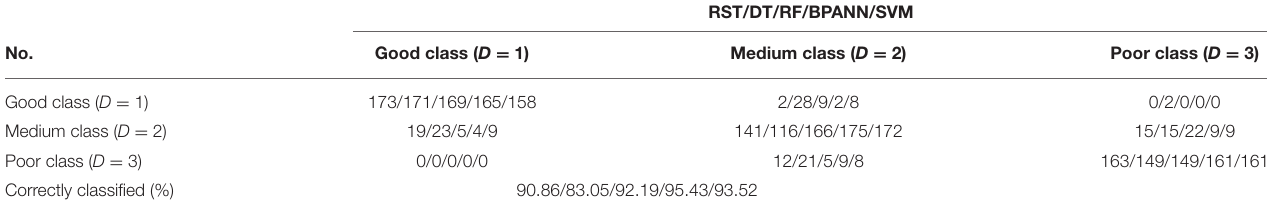
TABLE 3 | Average hit rates for 5-fold cross-validation.